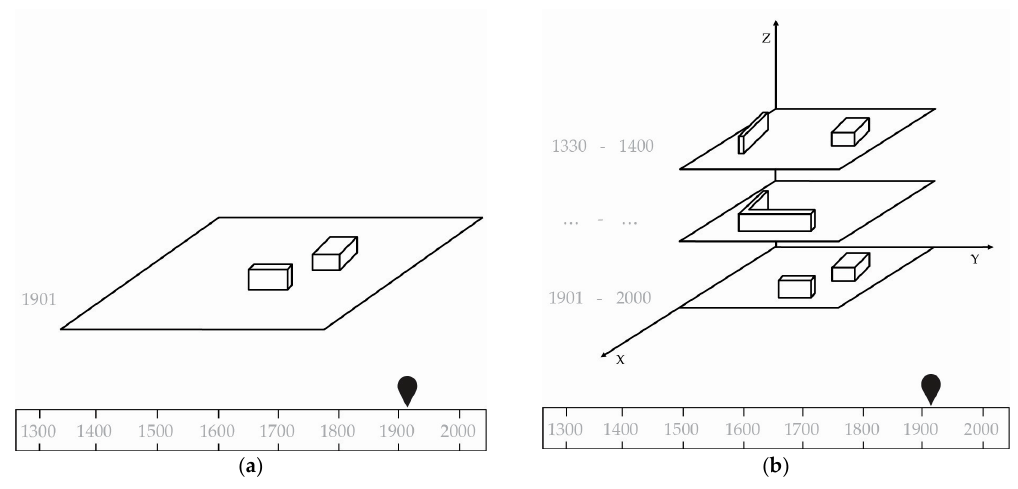
Figure 3. General design approach for spatiotemporal visualizations in ( a ) a slider-based visualization; and ( b ) a space–time cube.